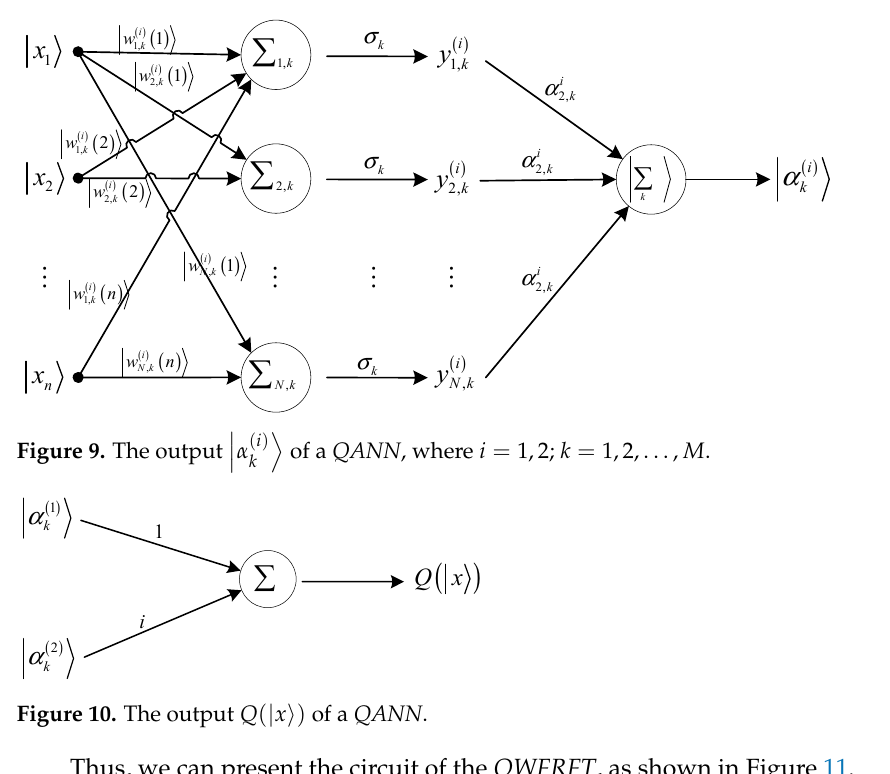
Figure 10. The output Q ( | x (cid:105) ) of a QANN .